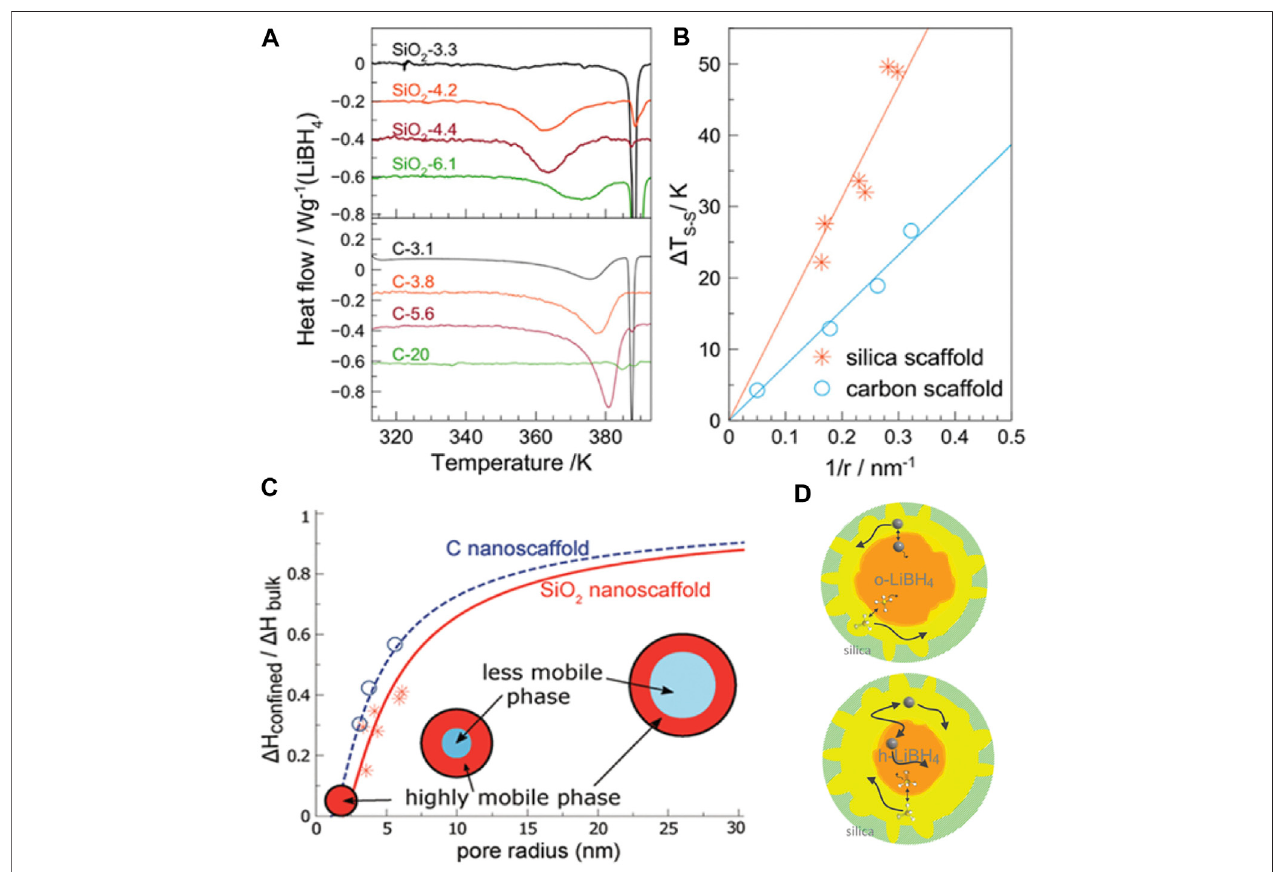
FIGURE 1 | Effect of nanocon fi nement on LiBH 4 : (A) differential scanning calorimetry pro fi le showing the other bottom of the pro fi le that originated from con fi ned LiBH 4 at a lower temperature than that of the bulk; (B) transformation temperature depression ( Δ T) as a function of the pore size for two different support materials; (C) ratioofenthalpyfromcon fi